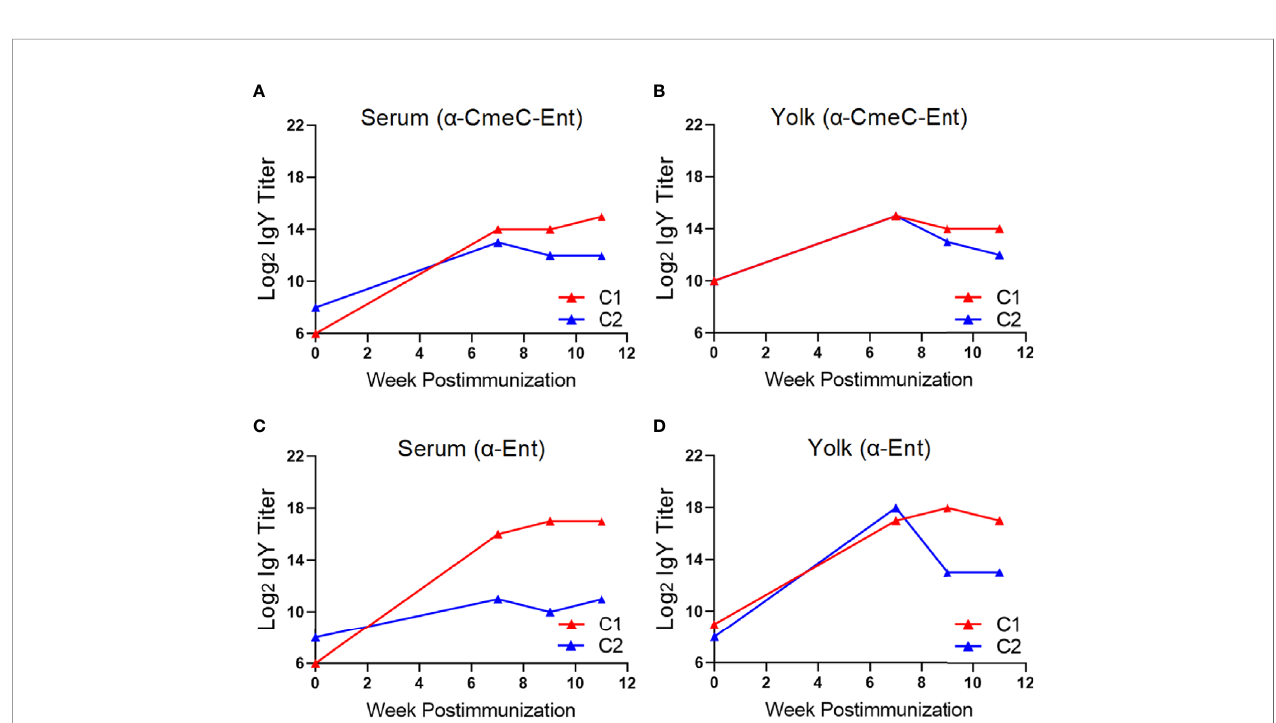
FIGURE 4 | Immune response of Rhode Island Red layers upon subcutaneous immunization with the CmeC-Ent conjugate (Trial #2). (A) Serum IgY titer against the CmeC-Ent conjugate. (B) Egg yolk IgY titer against the CmeC-Ent conjugate. (C) Serum IgY titer against Ent molecule. (D) Egg yolk IgY titer against Ent molecule. Each point represents mean IgY titer from duplicate measurements within single chicken. C1 and C2 denote the two individual chickens immunized with